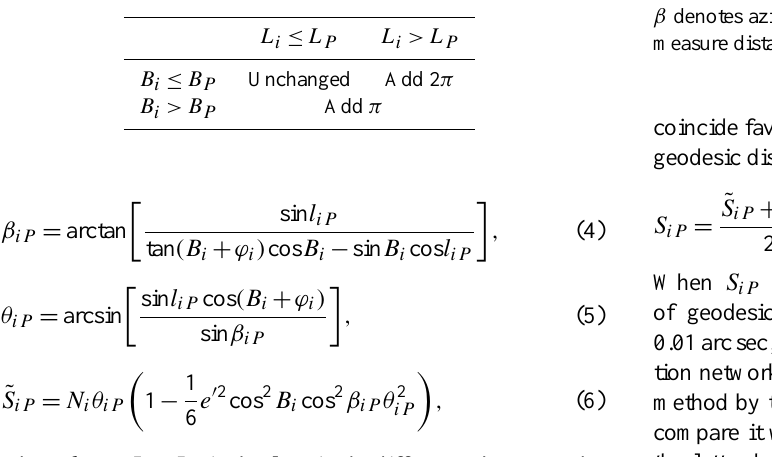
Fig. 2. The geodesic path S iP and the azimuth β iP and β Pi be- tween the i -th sensor and the lightning source position. P is the lightning location. Table 1. Adjustment of the calculated value of the geodesic az- imuth.